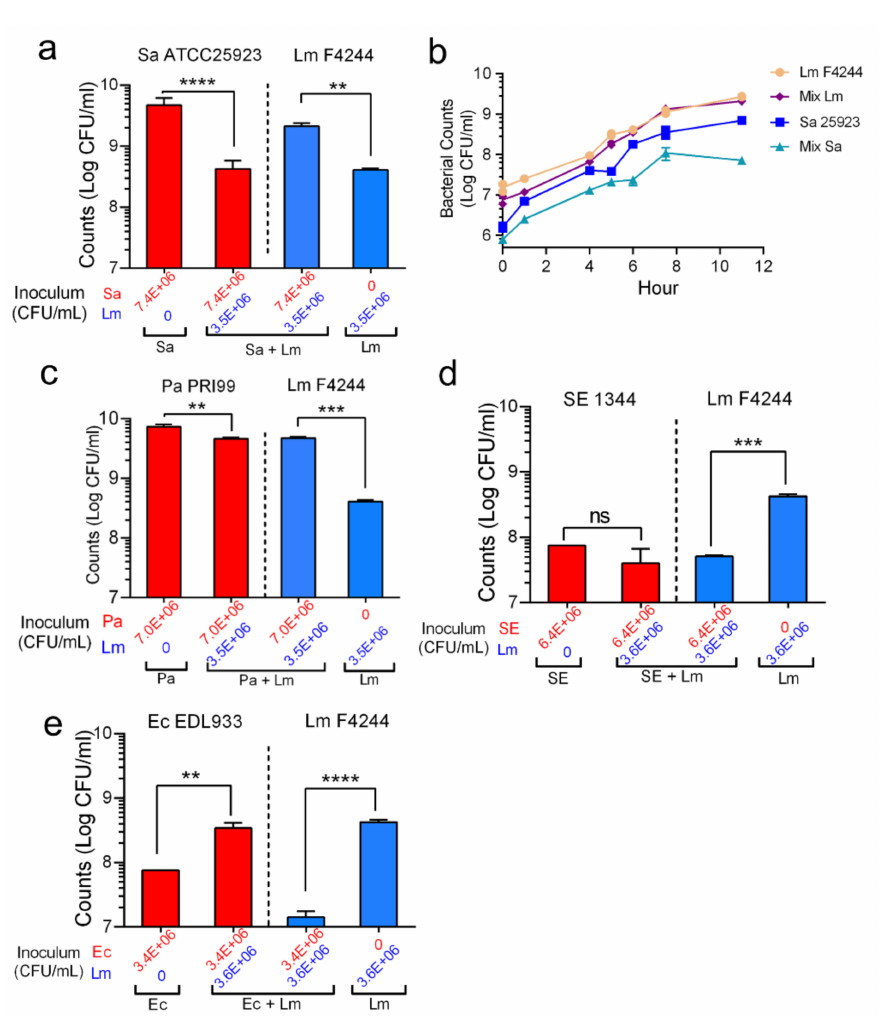
Figure 5. Quantification of bacterial counts in single and mixed culture biofilms. Bar graphs showing counts of ( a ) S. aureus ATCC25923 and L. monocytogenes F4244, ( b ) growth curve showing mono or mixed culture of S. aureus ATCC25923 and L. monocytogenes F4244, ( c ) bar graphs of P. aeruginosa PRI99 and L. monocytogenes F4244, and ( d ) bar graphs of S . Enteritidis 18ENT1344 (SE1344) and Lm F4244 ( e ), E. coli O157:H7 EDL933 (Ec EDL933) and Lm F4244 in their single or mixed biofilms. A pairwise Student’s t -test was used for statistical analysis. ** p < 0.005, *** p < 0.0005, **** p < 0.0001, ns, non